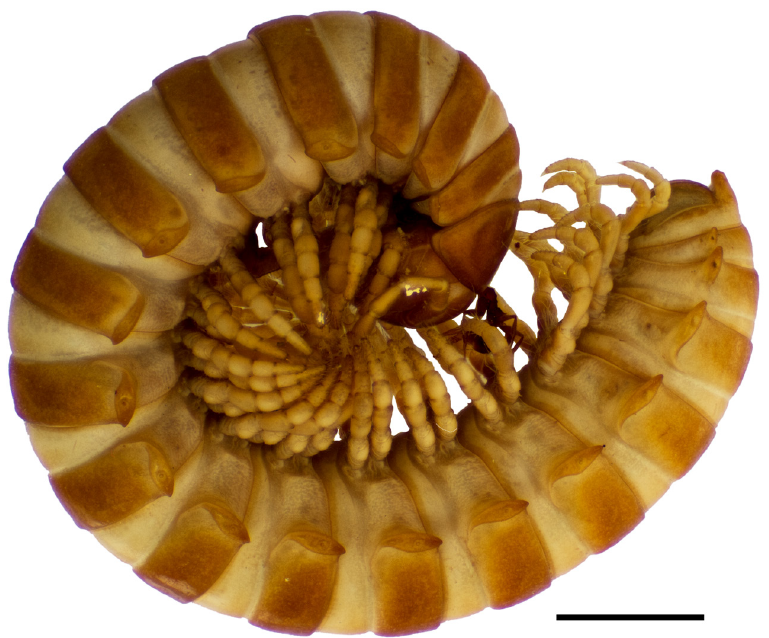
Fig. 6. Pogoro scharffi Hoffman, 2005, paratype, ♂ (NHMD 621669). Scale bar: 5